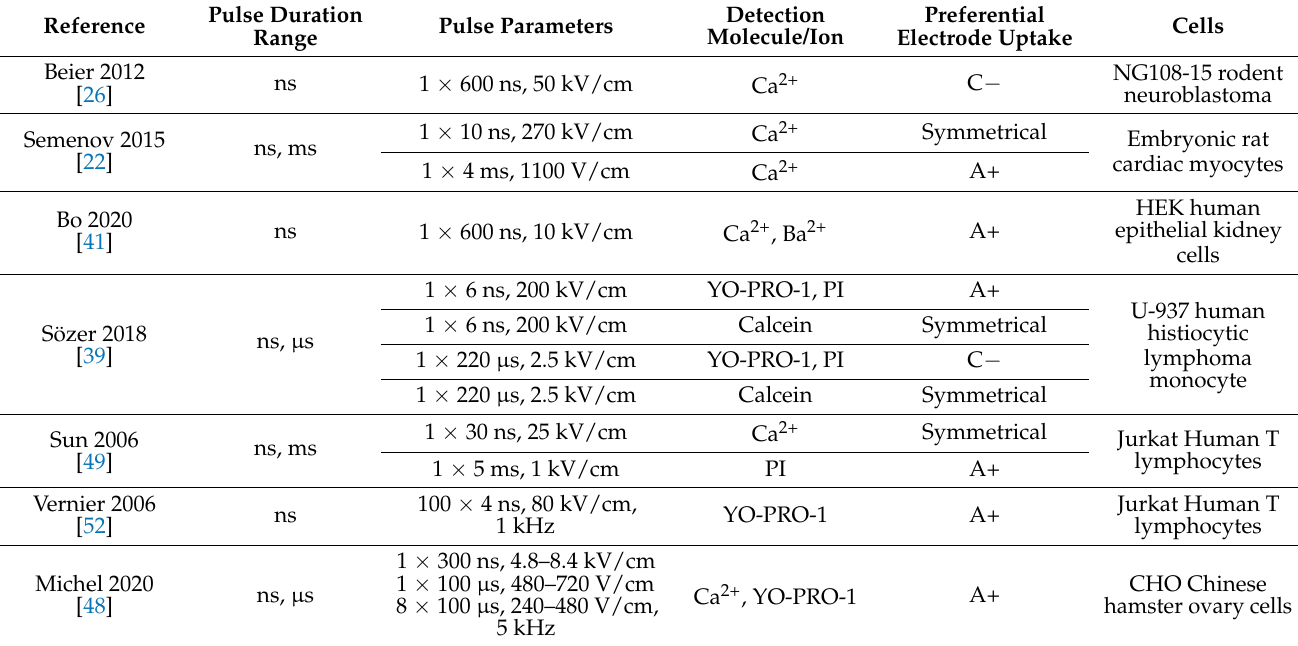
Table 1. References reporting (a) symmetrical uptake of molecules. Preferential electrode uptake: C − (cathode), A+ (anode),